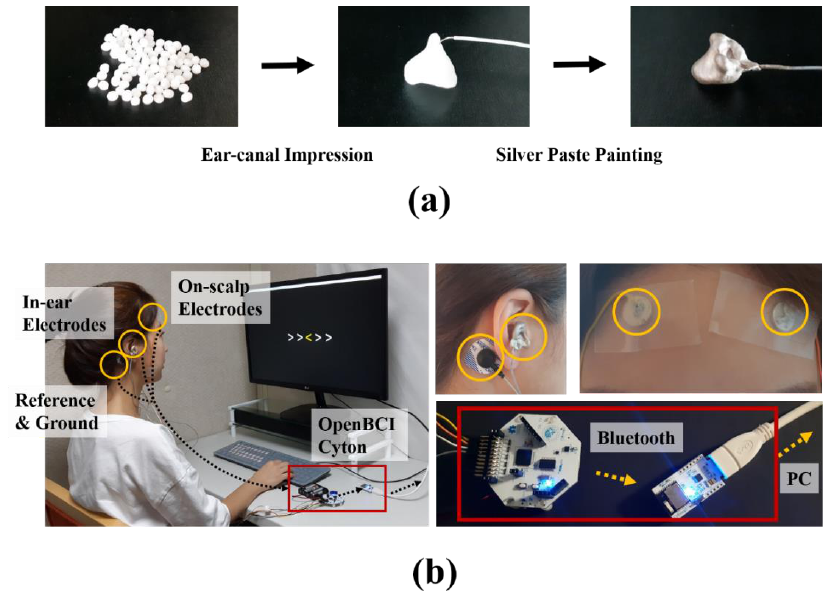
Figure 1. The design of the in-ear electroencephalography (EEG) electrodes. ( a ) Impressions were